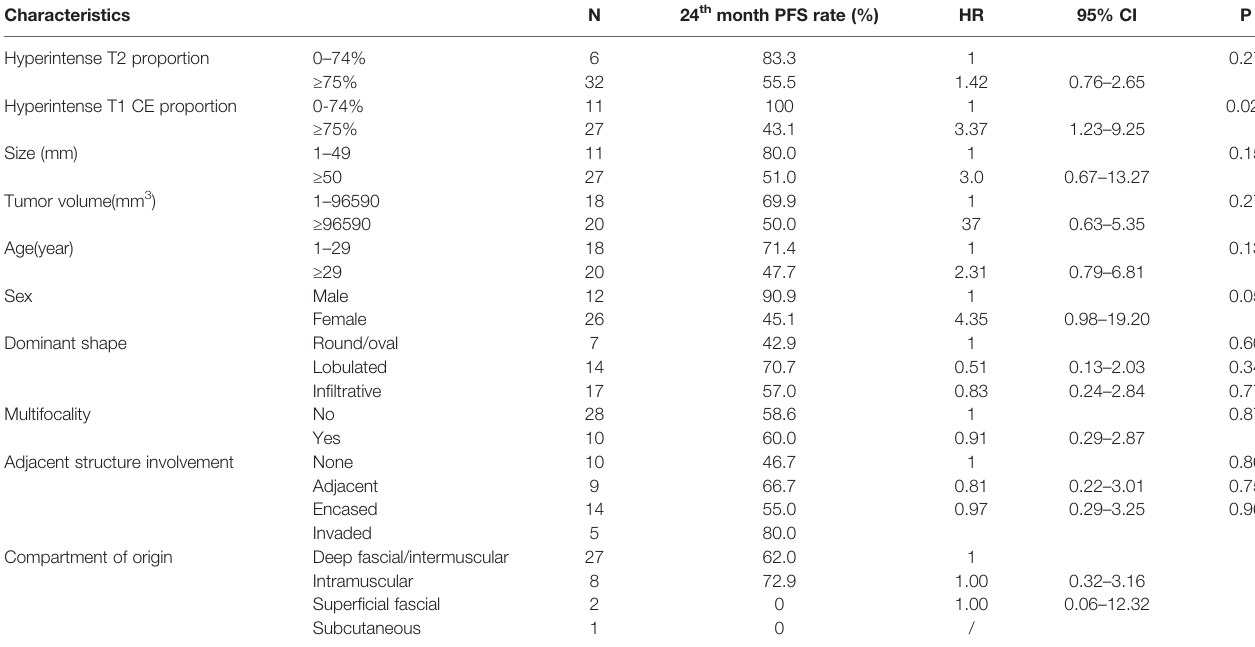
TABLE 4 | Univariate analysis of clinical and radiographic characteristics for PFS.